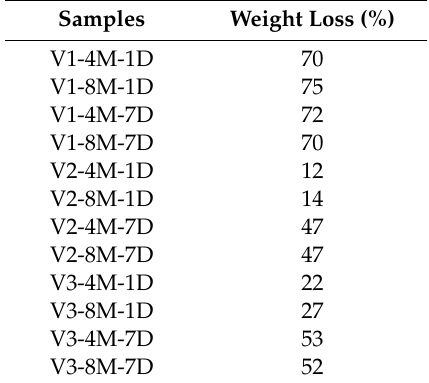
Table 2. Weight loss (%) in the treated samples.